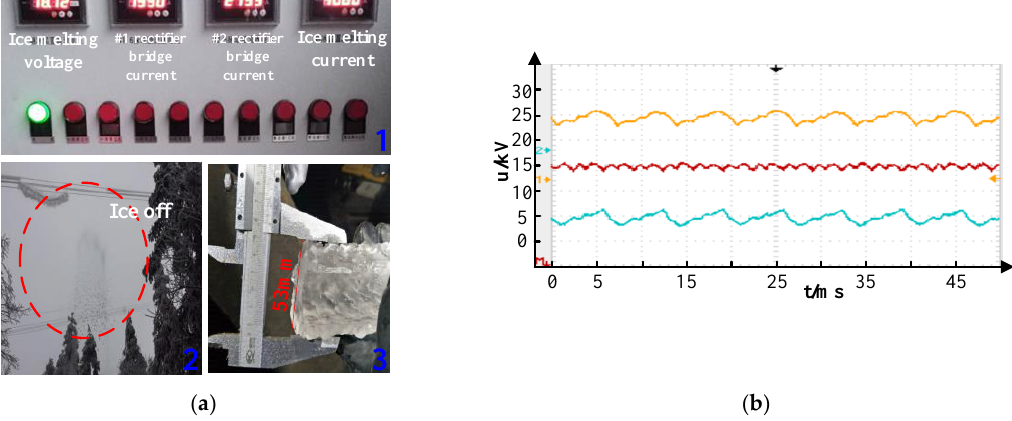
Figure 13. Low-harmonic DC ice-melting device in 35 kV Chuanshan substation.